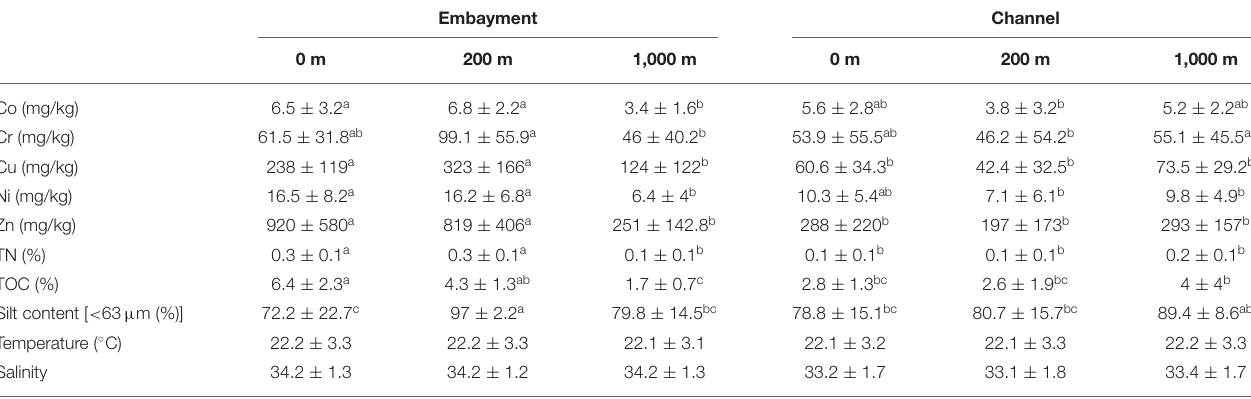
TABLE 1 | Environmental characteristics (mean ±